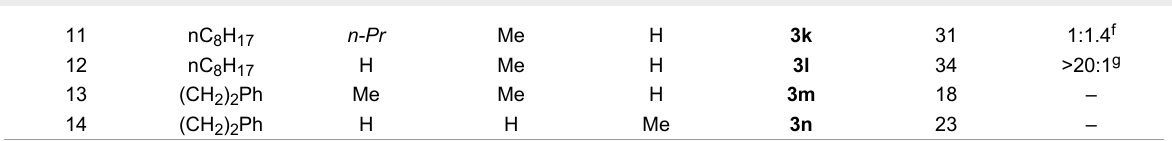
Table 2: Scope of the carboalkoxylation of sulfonyl acetylene ( 1 ). a